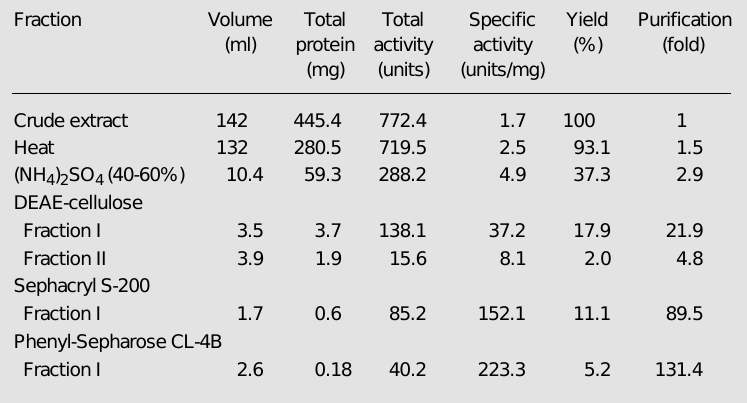
Table 4 - Purification of the major constitutive alkaline phosphatase synthesized by the wild 74A strain of N. crassa grown in non-buffered high-Pi medium at 30 o C, supple- mented with 44 mM acetate as the carbon source and adjusted to pH 7.1. For details, see Material and